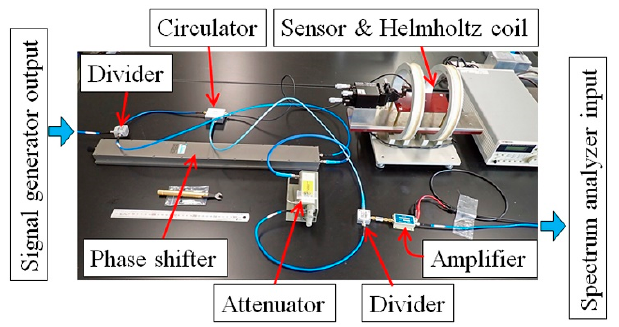
Figure 19. Enlarged view of the carrier-suppressing circuit connected with the sensor.